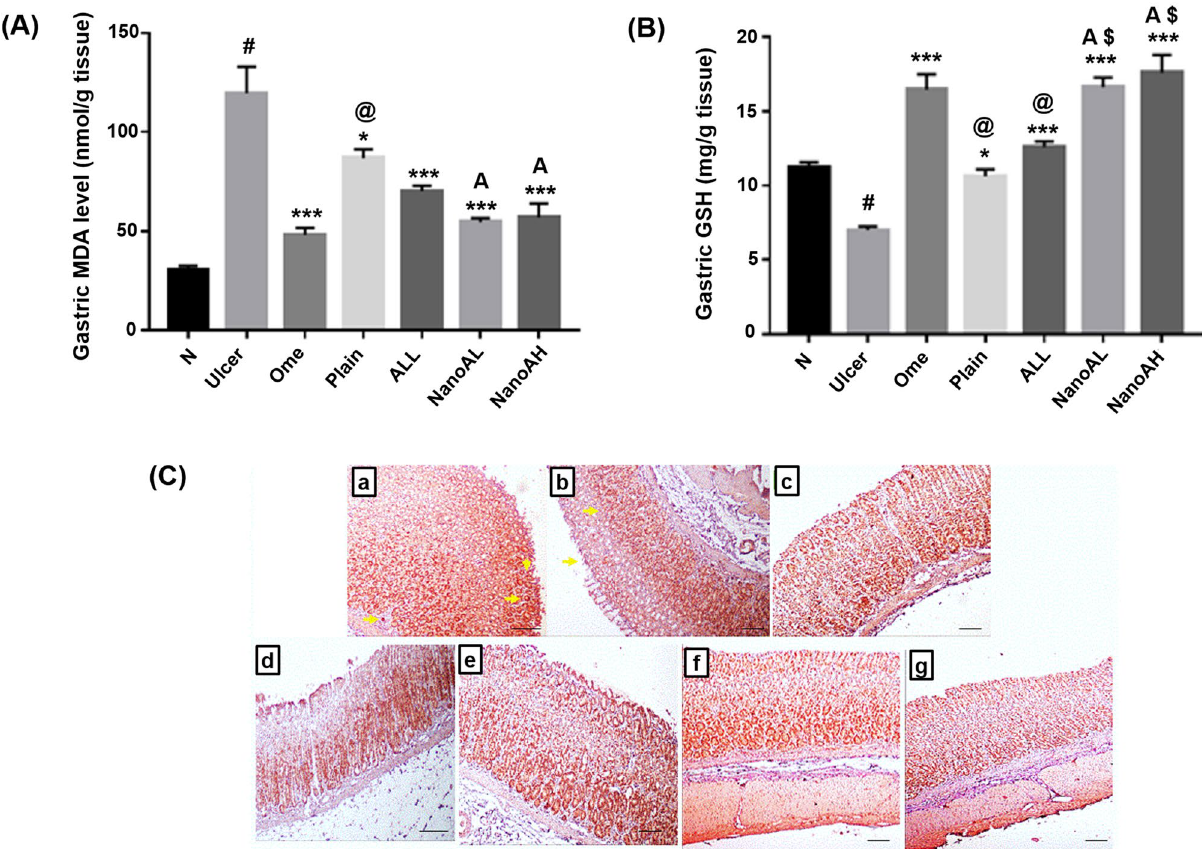
Figure 11. Oxidative status of ( A ) gastric MDA (nmol/g tissue) and ( B ) gastric GSH (mg/g tissue) in rats’ gastric tissues. ( C ) Immunostaining of Nrf-2 in rats’ gastric tissues (X: 100). (a) N group, (b) ulcer group, (c) ome group, (d) plain group, (e) ALL group, (f) NanoAL group, and (g) NanoAH group. X: 100. Data are expressed as mean ± SEM, # p < 0.001 compared to N group, * p < 0.05 compared to ulcer group, *** p < 0.001 compared to ulcer group, @ p < 0.01 compared to ome group, $ p < 0.001 compared to ALL group, A p < 0.05 compared to plain group using GraphPad Prism 5.00 (http://www.graph pad.com). Positive stainings are shown by yellow group ( p < 0.05 and p < 0.001, respectively) but not as Ome group. Both CS and ALL are well-documented for their antioxidant effects 7,68–70 .